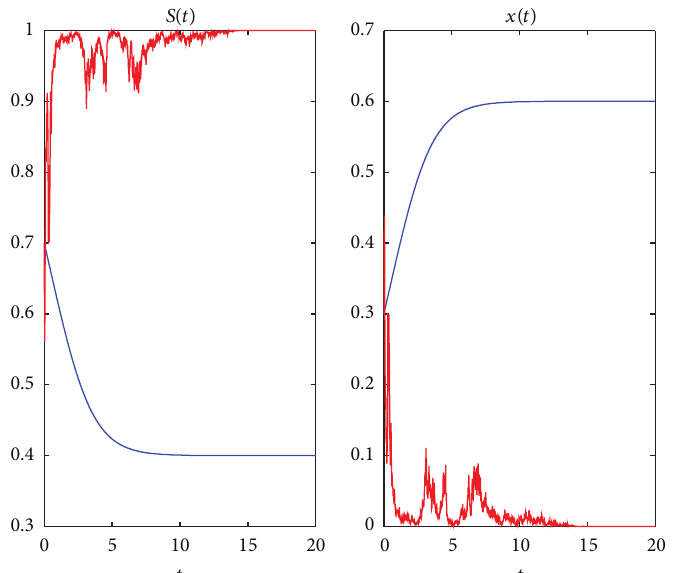
Figure 3: Deterministic and stochastic trajectories of simple chemostat model for initial condition 𝑆 0 = 0.7 ; 𝑥 0 = 0.3 ; and 𝑆 0 = 1 , 𝑚 = 2 , 𝑎 = 0.6 , 𝐷 = 0.8 , and 𝛼 = 1.55 .